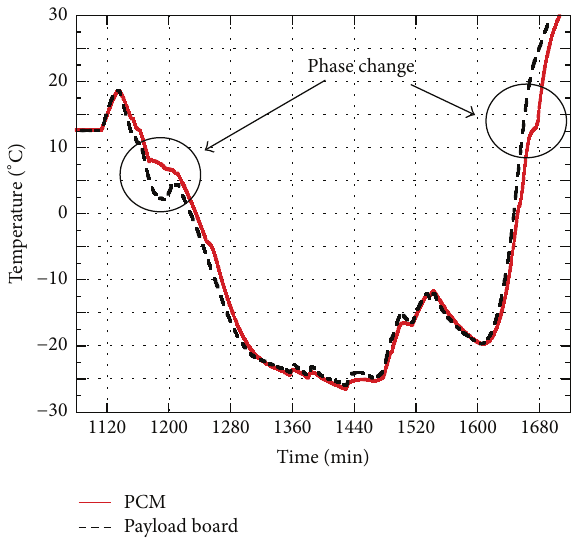
Figure 18: Temperature profile of the